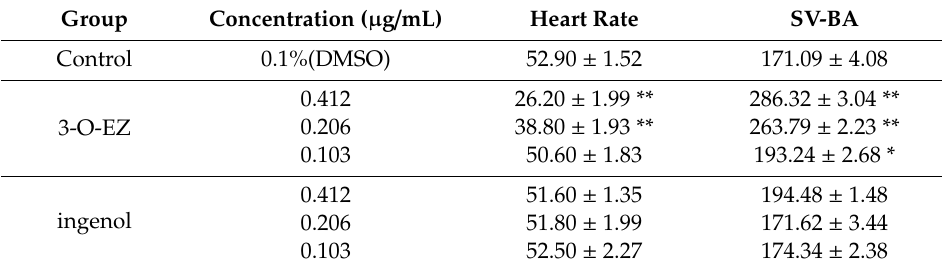
Figure 2. UPLC of the 3-O-EZ and ingenol in Euphorbia kansui (EK) and EK stir-fried with vinegar (VEK).